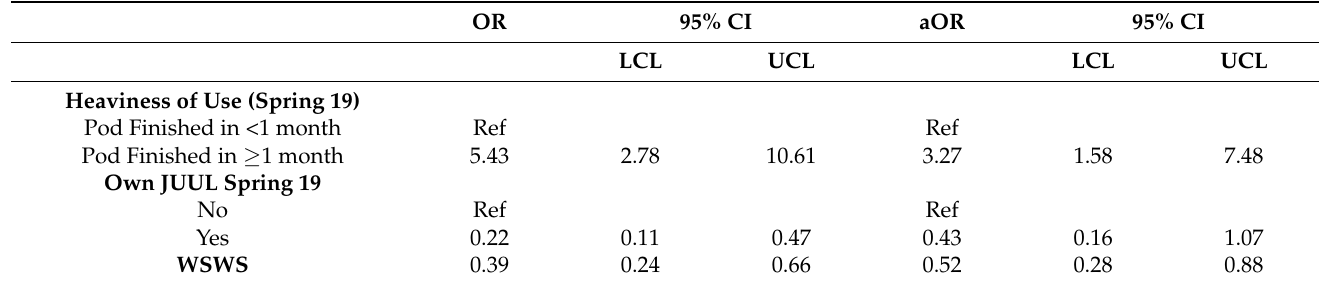
Table 4. Factors associated with long-term quit attempts among current JUUL